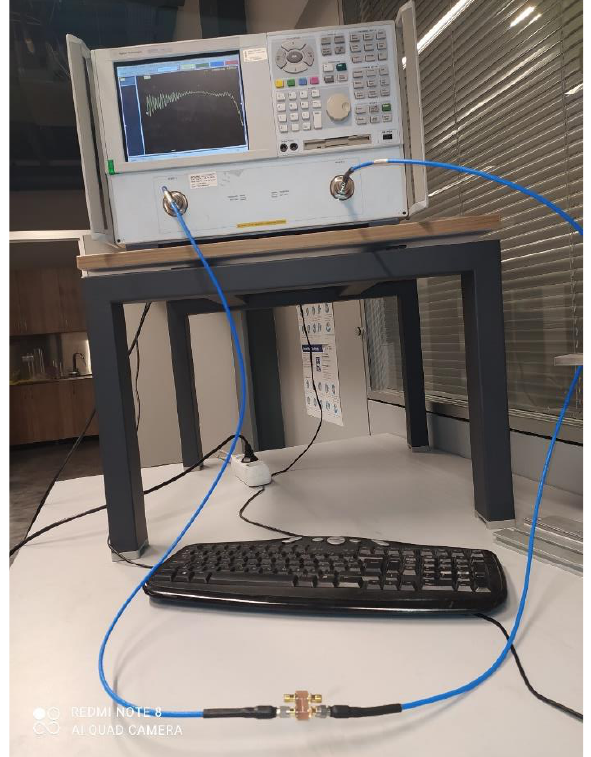
Figure 5. The measurement results